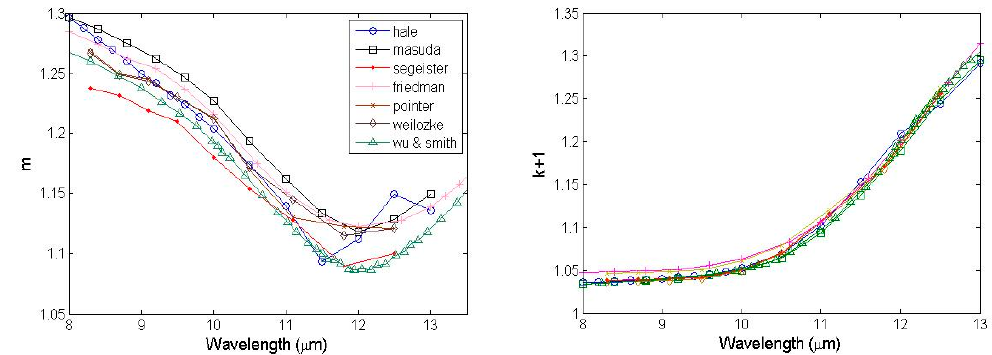
Figure 1. Spectral variation of refractive indices (n = m − ik) obtained from different sources. Left : real part; right : imaginary part. part; right : imaginary